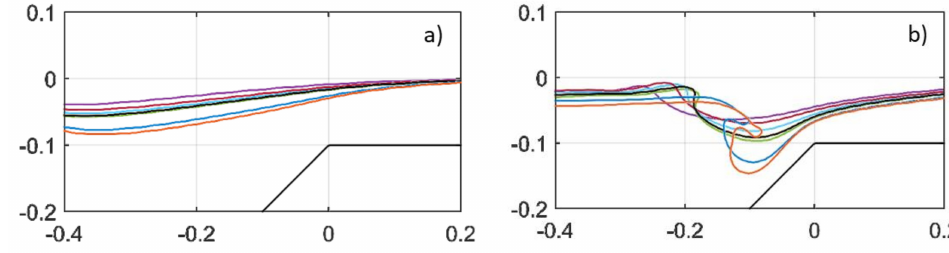
Figure 10. The comparison of the free-surface profiles in the near-shore region at: ( a ) t = 0.4 s and ( b ) t = 0.8 s. The legend is as same as Figure